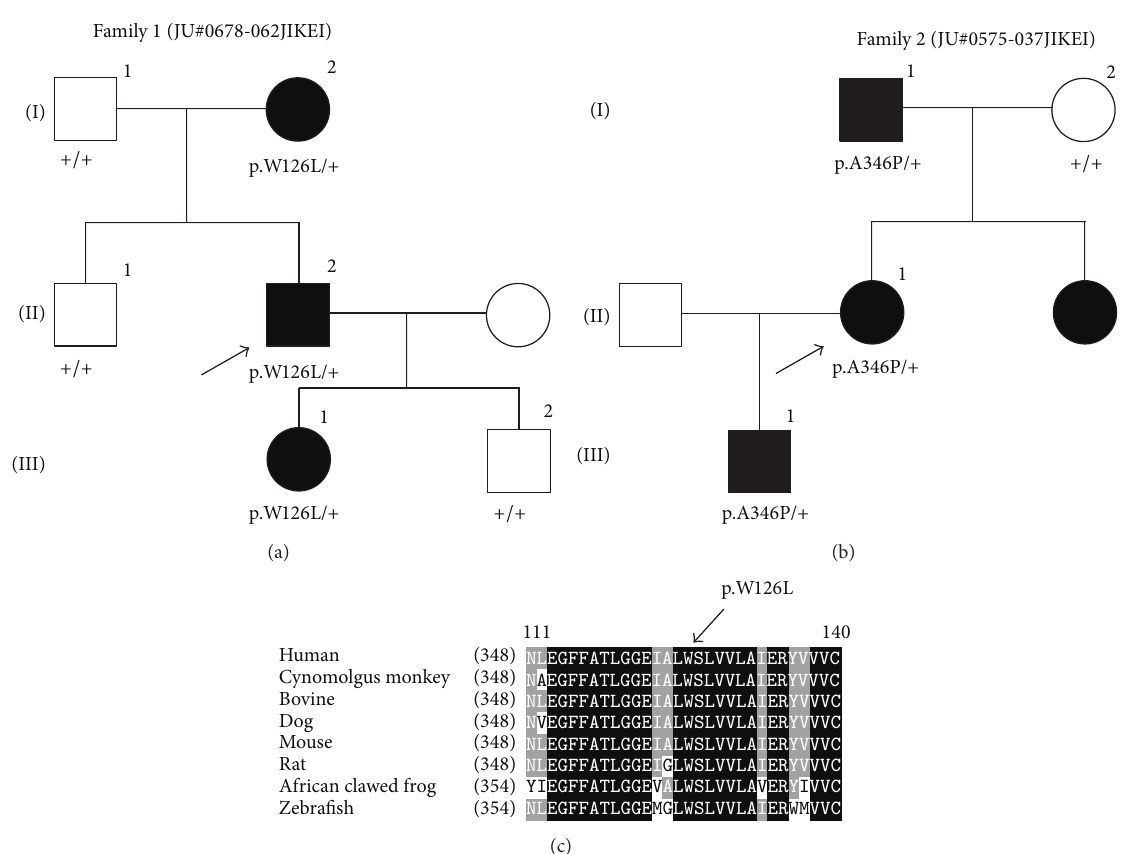
Figure 1: Pedigrees of the two Japanese families with RP and amino acid sequence alignment of the rhodopsin in different vertebrate species. (a) and (b) The solid squares (male) and circles (female) represent the affected individuals. The proband of each family is indicated by the arrows. (c) The tryptophan residue at position 126 is highly conserved. The conserved amino acids between the different species are shown in the black boxes. The less and least conserved amino acids are highlighted in the gray or white boxes,